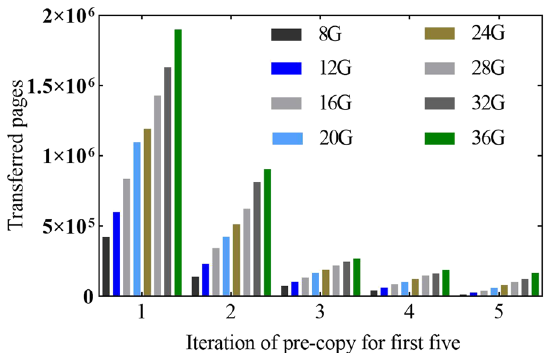
Fig. 2 Number of memory pages transferred in first five pre-copy iterations when migrating a VM running lmbench load for different memory size